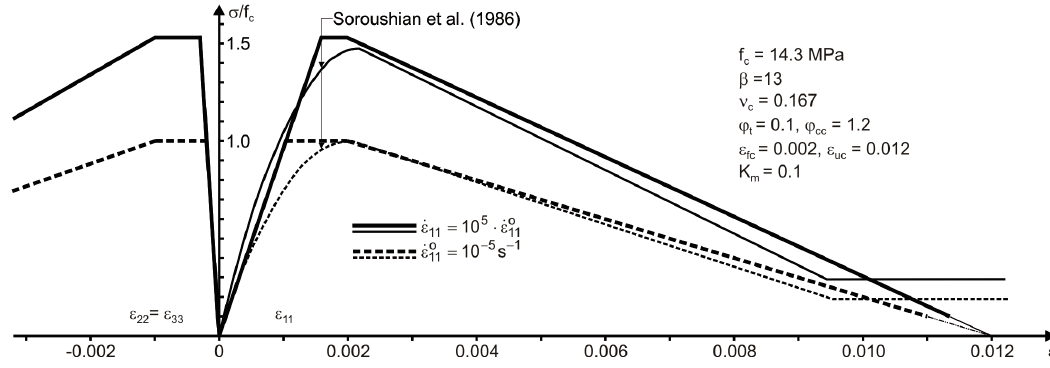
Figure 16. Comparison of the proposed model with theoretical model by Soroushian at al. [15].